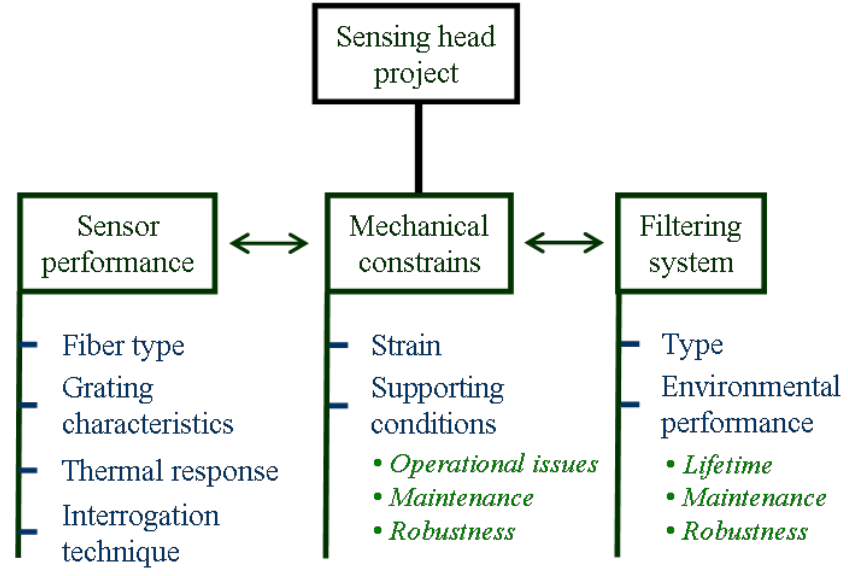
Figure 1. Schematic of the issues and parameters to take in consideration when projecting a sensing head to operate in natural aqueous